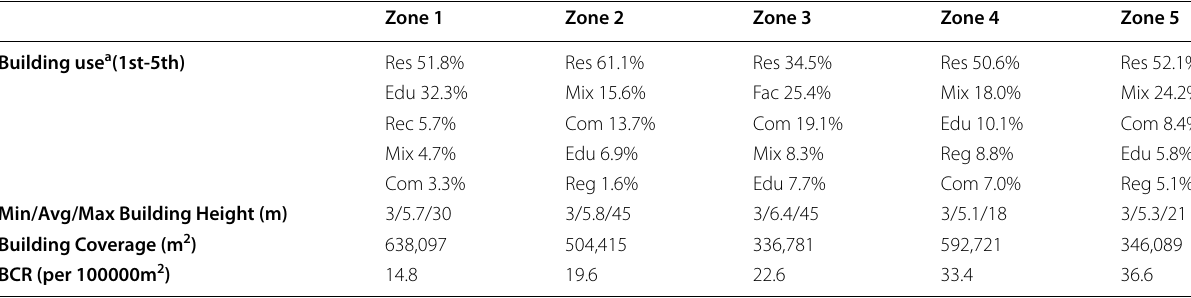
Table 1 Building use, height, coverage, and coverage ratio in the five